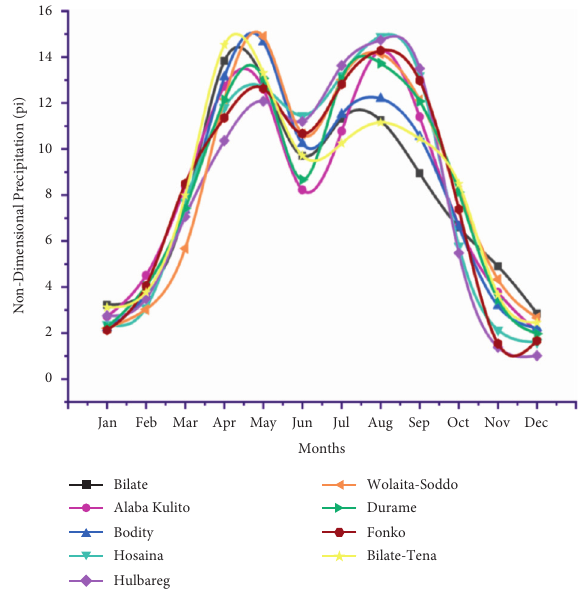
Figure 3: Homogeneity test of rainfall data.